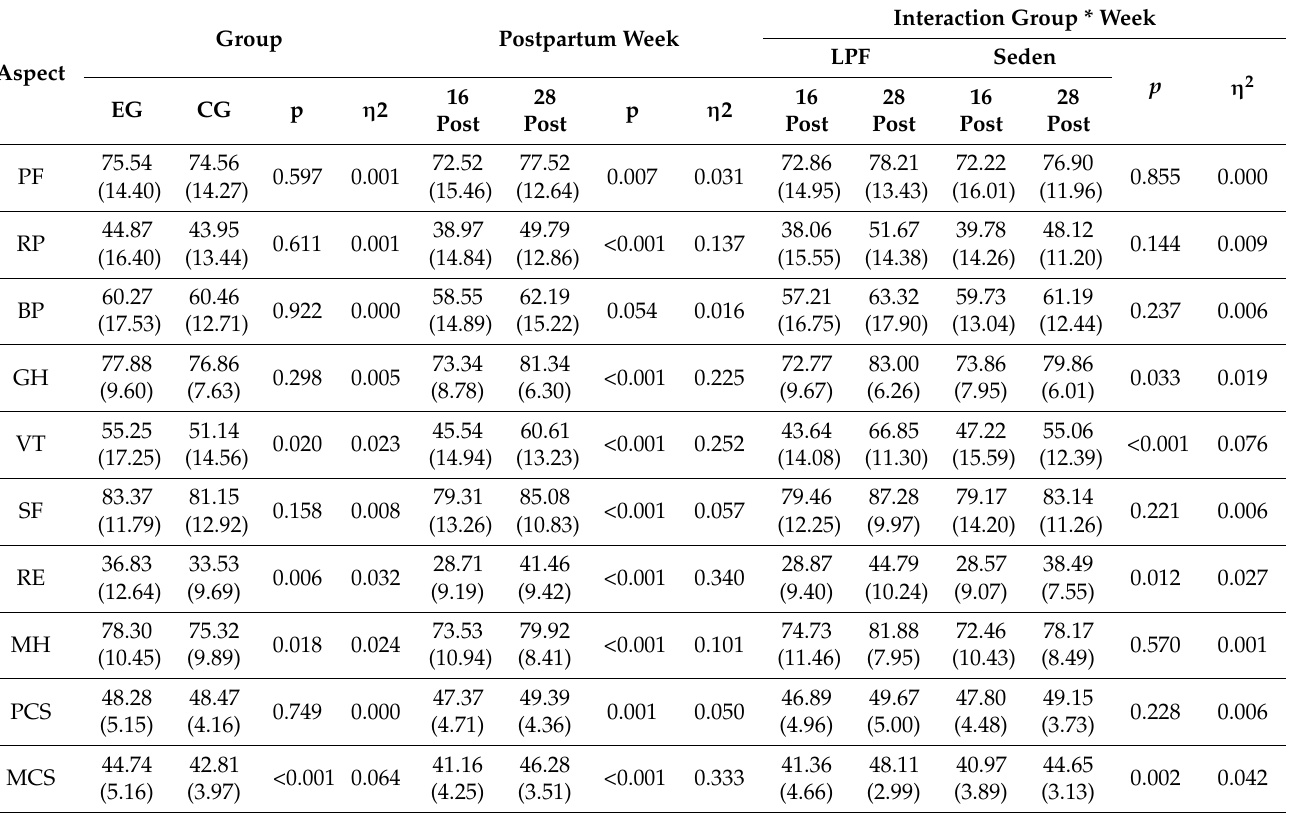
Table 2. Average score (SD) per group, postpartum week and interaction group * week. (EG, n = 56; CG, n =